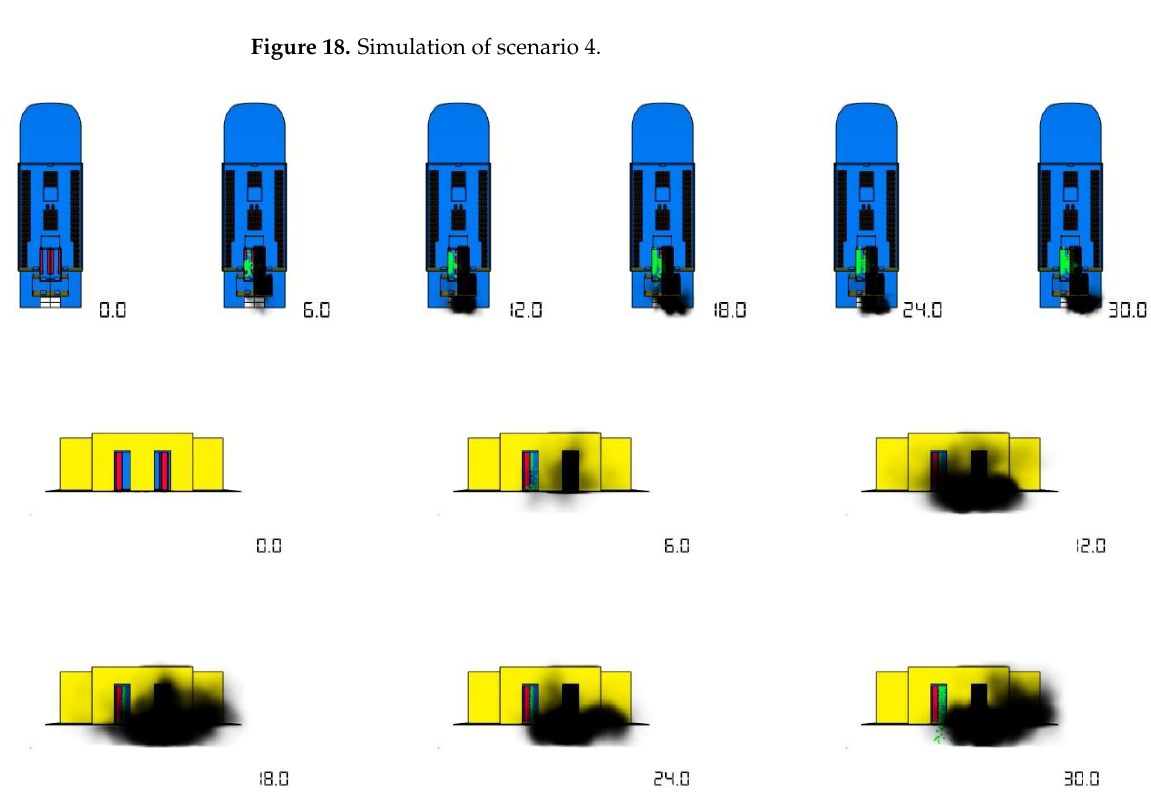
Figure 19. Simulation of scenario 5.